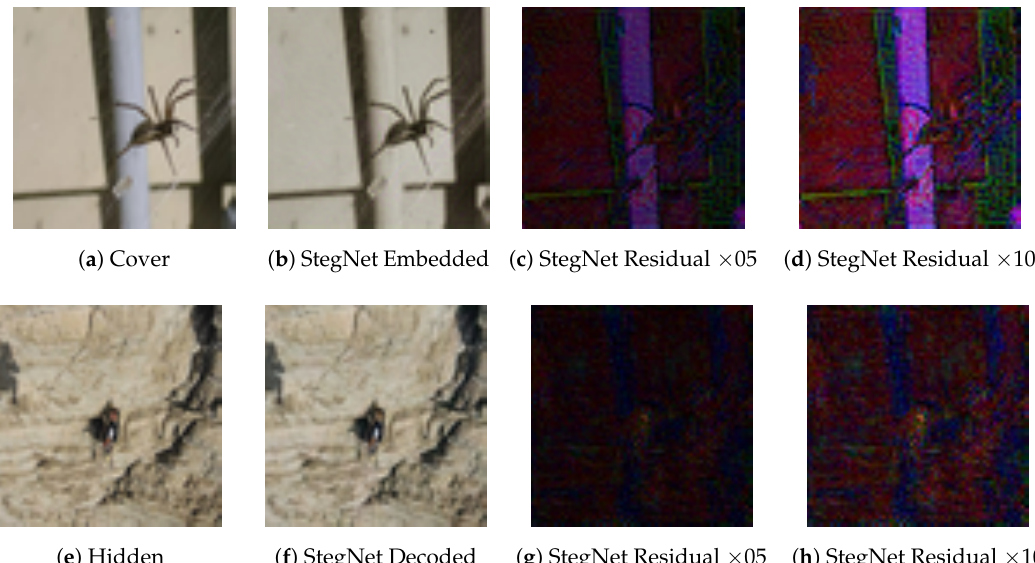
Figure 6. StegNet residual images “ × 05” and “ × 10” are the pixel-wise enhancement ratio.